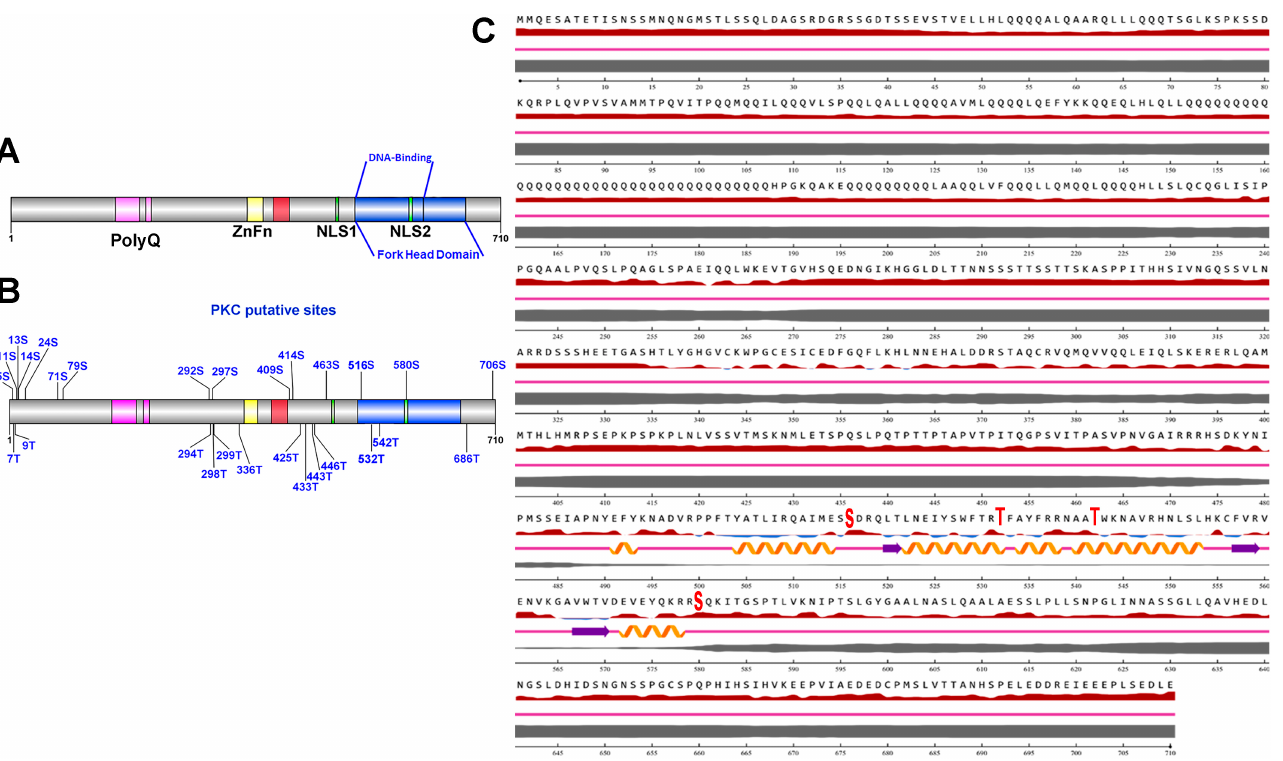
Figure 6. Bioinformatic analysis of rat FOXP2 PKC phosphorylation sites. ( A ) Map of FOXP2 protein domains (NP_001258033.1): pink = polyglutamine (Poly-Q), yellow = zinc finger (ZnFn), red = leucine zipper, green = nuclear localization signal 1 and 2 (NLS1 and NSL2) and blue = Forkhead. ( B ) Scheme showing putative PKC phosphorylation sites in FOXP2. ( C ) Sequence and secondary structure of FOXP2 obtained by NetSurfP-2.0. Helix, Strand, and Coil. The relative surface accessibility is represented by the red (exposed sites) and blue (buried sites), and the percentage of the disorder is represented by the gray line, where the thickness is directly related to the level of disorder of each residue.